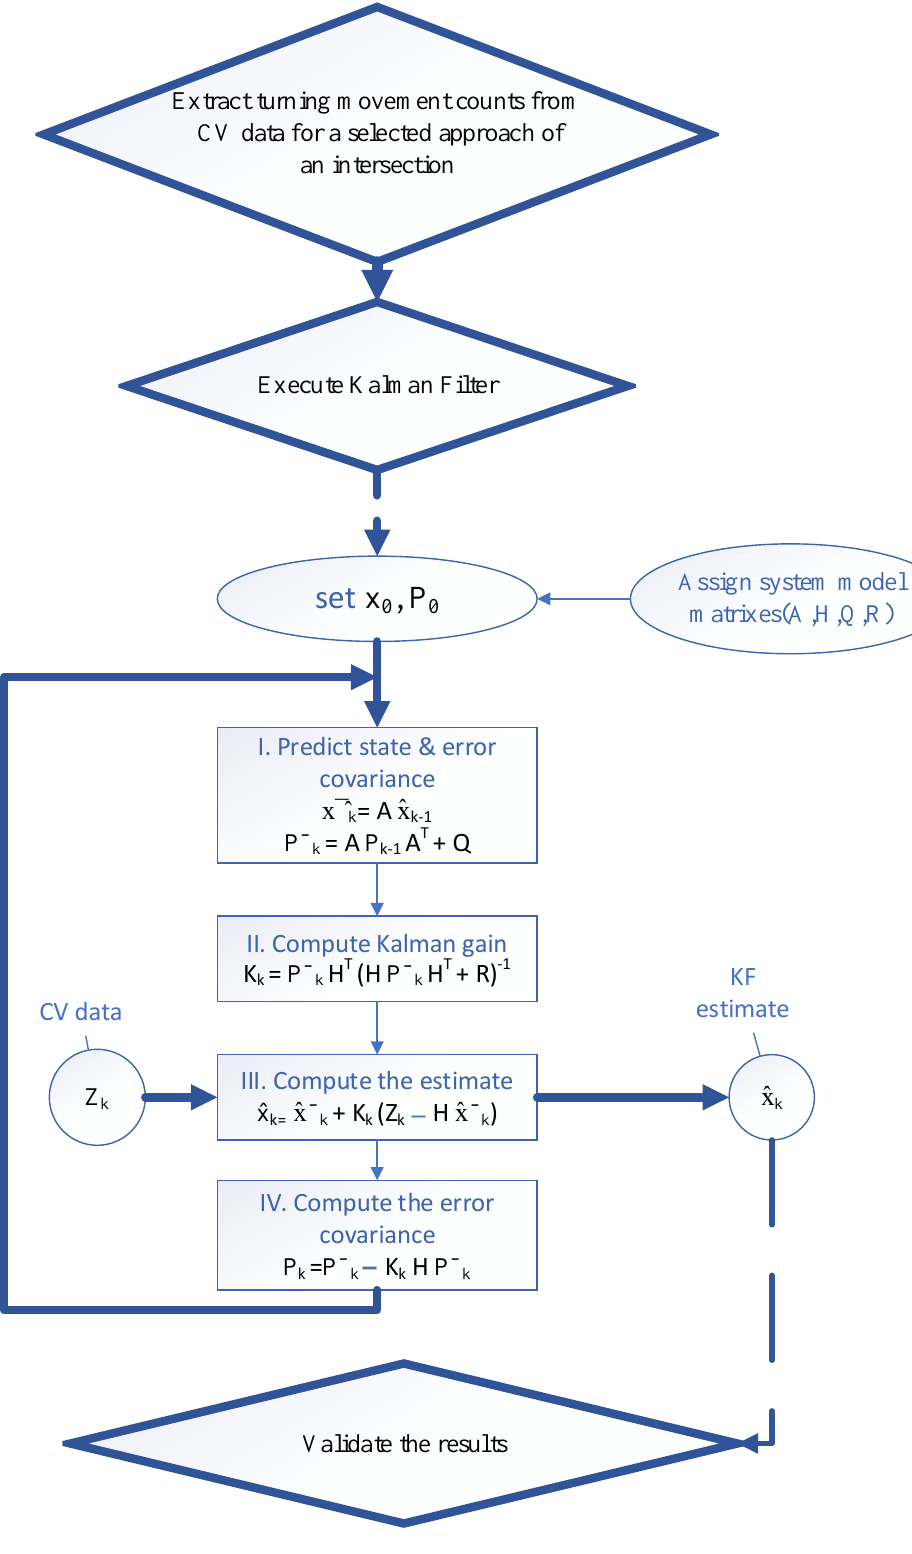
Figure 5. Kalman Filter Algorithm.